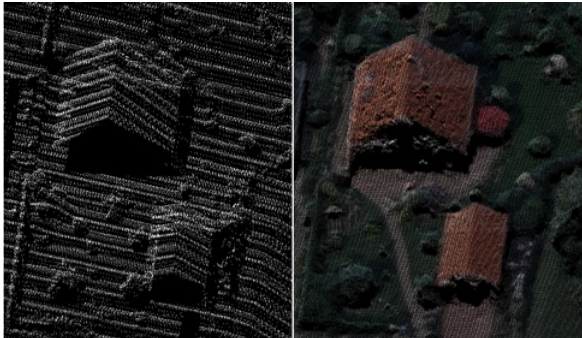
Figure 1. Example of an ALS point cloud (left) and a DIM point cloud